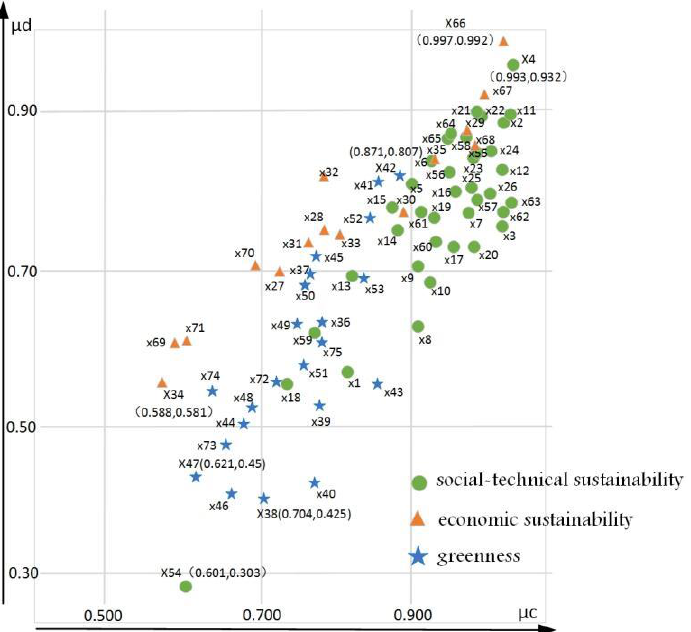
Figure 1. Scatter distribution of “designers-constructors” membership. Note: µ C and µ D represents the membership values of the indicators in A C and A D , respectively.